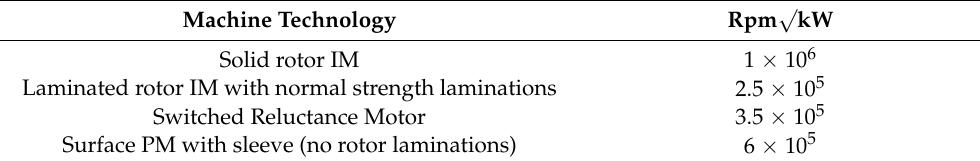
Table 1. Summary of high speed machine limits.